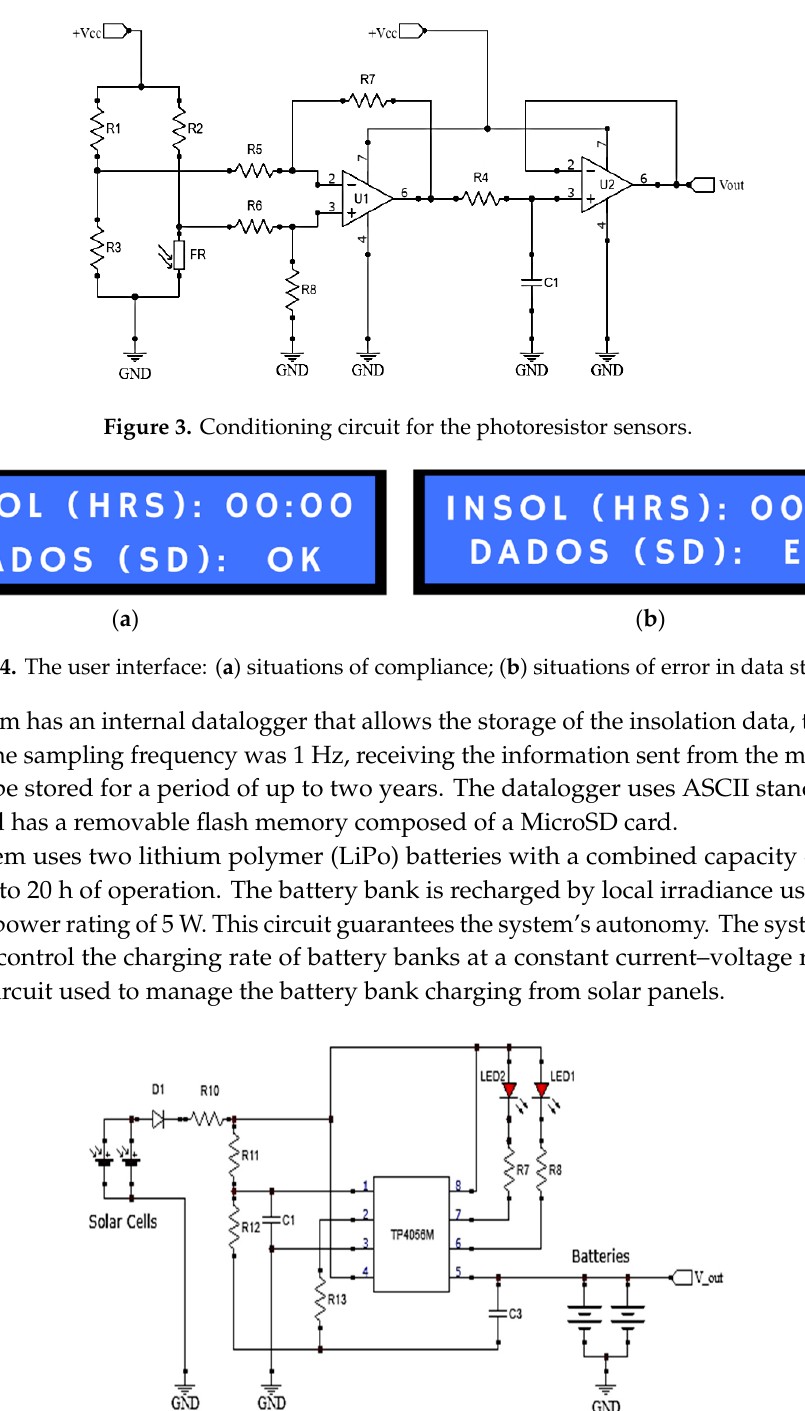
Figure 5. Circuit for battery charging.